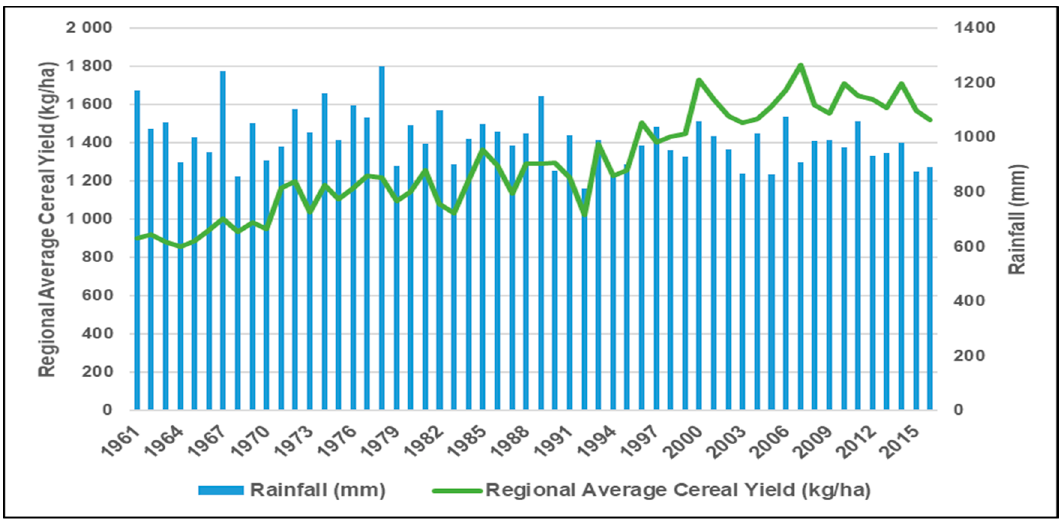
Figure 7. Relational trends between rainfall variability and cereal production in Southern Africa over time. Reproduced with permission from FAO, AQUASTAT Database; and World Bank, World Bank Indicators, 2020.